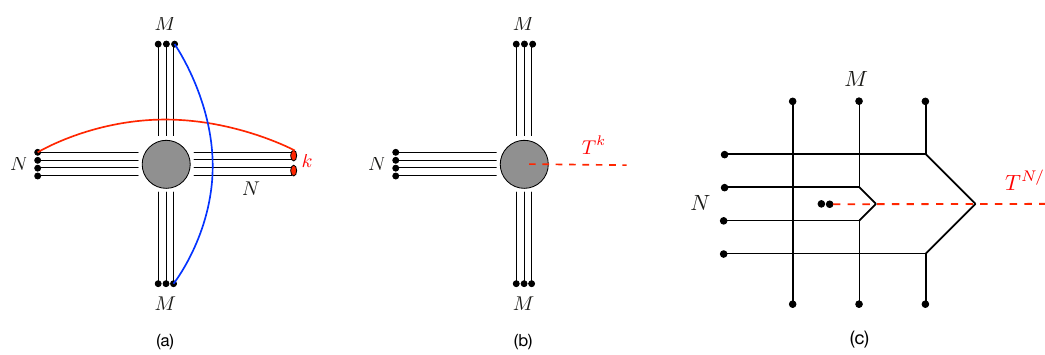
Figure 5. The + N;M;k theory: (a) The N D5-branes on the r.h.s. end on k D7-branes in groups of N=k . (b) An equivalent description with the k D7-branes in the interior. (c) Deformation to an IR quiver gauge theory for k = N=